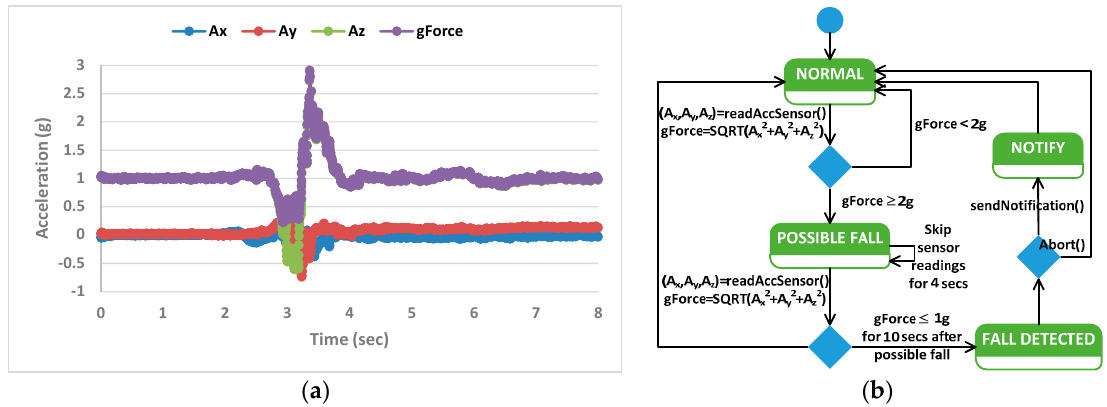
Figure 9. ( a ) Acceleration signal variance during a fall incident; ( b ) fall detection algorithm state diagram.